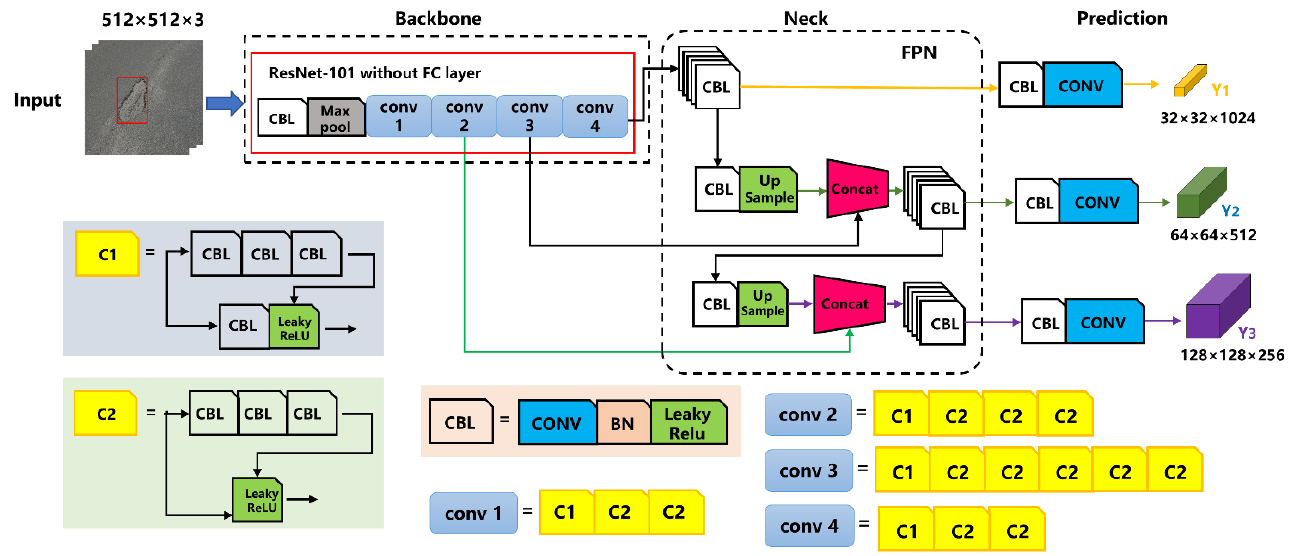
Figure 2. YOLOv3–ResNet101 network structure.